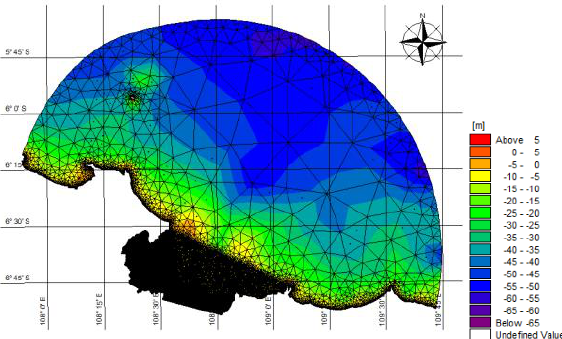
Figure 2. Unstructured grid and mesh in tidal